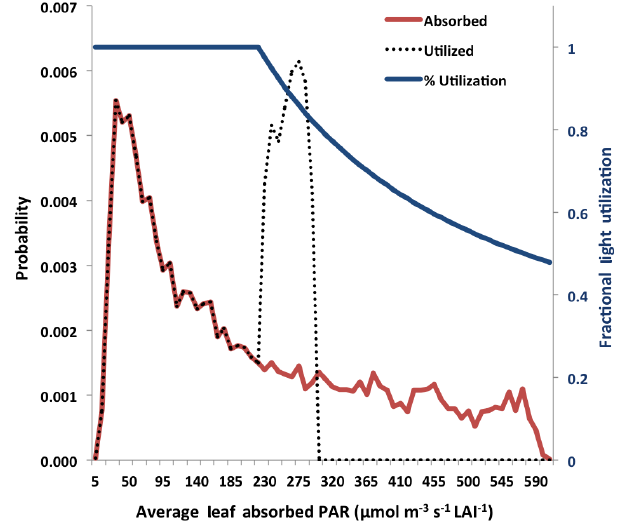
Figure 2. Probability distribution of average leaf-absorbed PAR ( l APAR, red) and absolute light utilization (dashed black) for the September 13:00 DART simulation. Fractional light utilization (blue) for different l APAR values is plotted on the right y axis, based on leaf measurements of light saturation from Kitajima et al. (1997). Absolute light utilization (dashed black) is the product of l APAR (red) and fractional light utilization (blue). Light satu- ration reduces the effective leaf absorption for voxels with average l APAR>225µmolm − 3 s − 1 LAI − 1 .